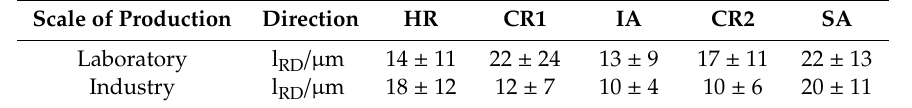
Table 3. Microstructural parameter for laboratory and industrially produced EN AW-5182 sheets